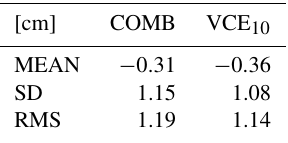
Table 8. SLR validation of combined orbit computed by GMV (COMB) and combined solution using variance component estima- tion (VCE 10 ).